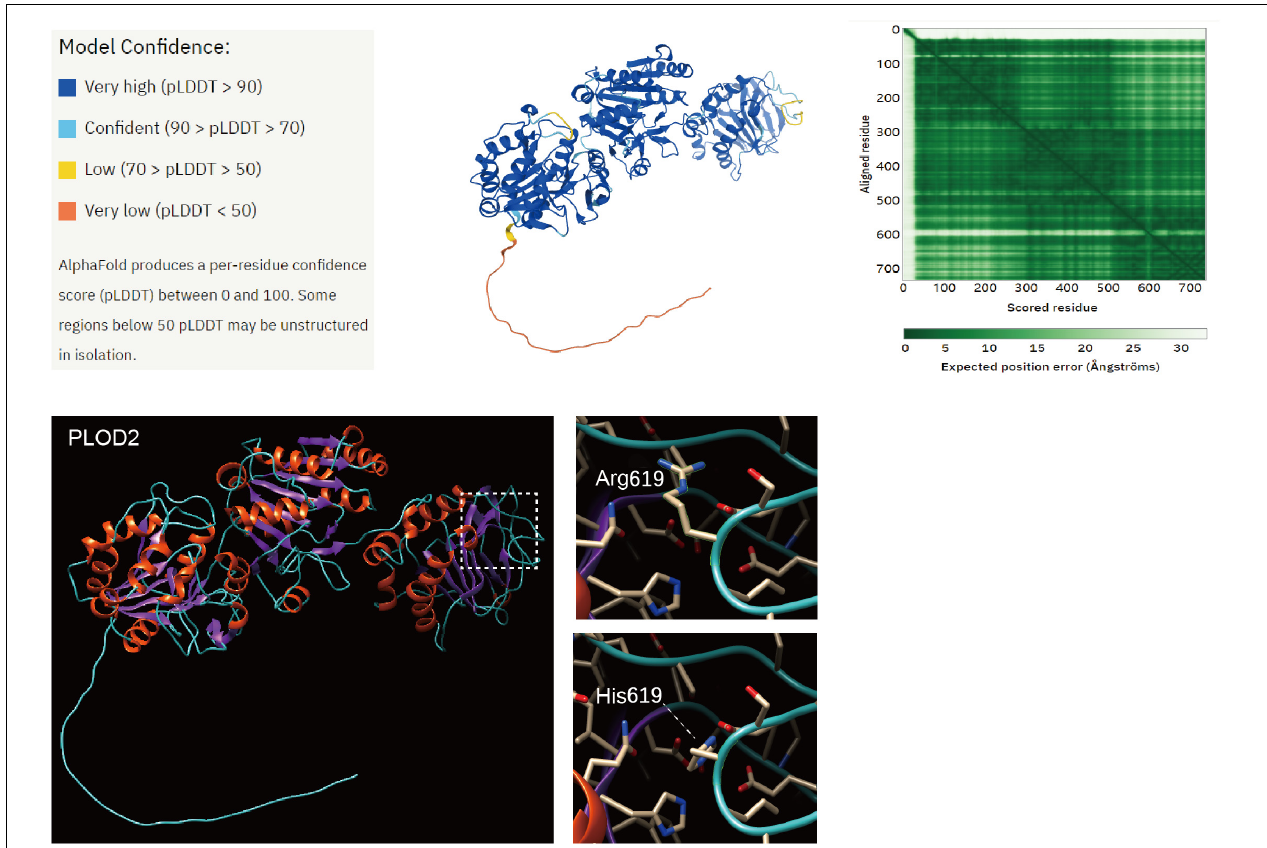
FIGURE 5 | Structure prediction of PLOD2 protein variant. The tertiary structure of the PLOD2 protein was predicted by AlphaFold (https://alphafold.ebi.ac.uk/ entry/O00469). Model confidence was ranked by four levels and colored in a tertiary structure. The heatmap shows the confidence in the PLOD2 protein. The first 30 amino acids of the N-terminal of the PLOD2 protein in this model had little accuracy of model confidence, while the other region of PLOD2 protein has desirable confidence. We loaded this predicted model in Chimera 1.15, and the structural change of PLOD2 influenced by an R > H substitution in position 619 (LH2b) of the protein was exhibited and the variant site was labeled. AlphaFold was used to predict the structural changes of p.Arg619His variant, and it was found that this variant may lead to wrong protein